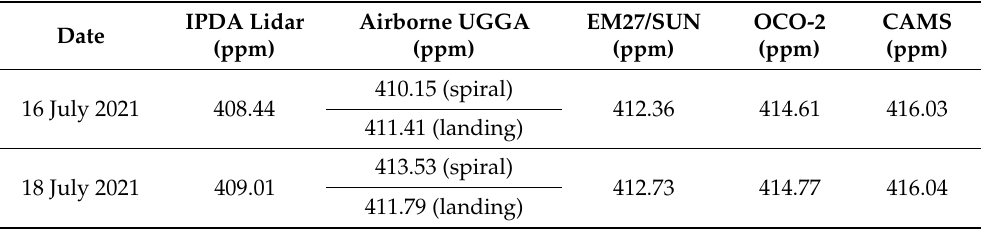
Table 3. Comparison results of XCO2 data from IPDA lidar, airborne UGGA, CRCS ground station